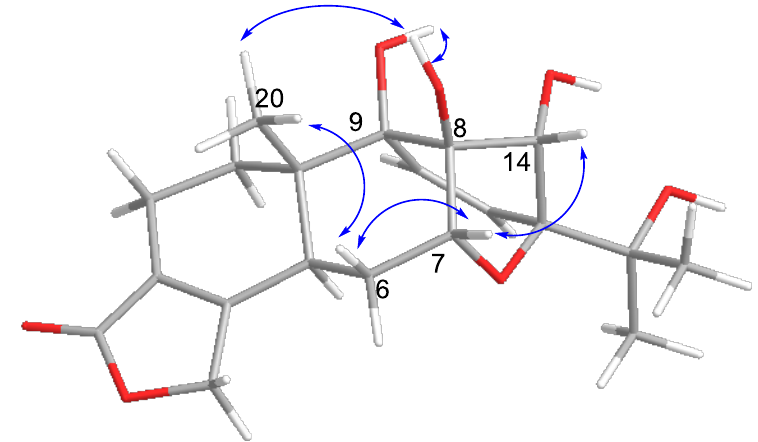
Figure 3. Key NOESY correlations of compound 1 .